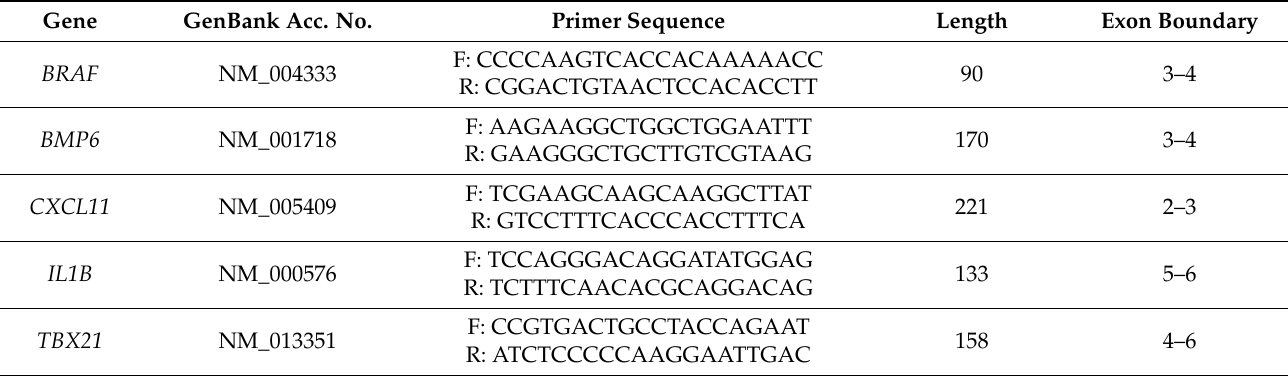
Table 6. Sequence of primers used for PCR. Gene GenBank Acc.